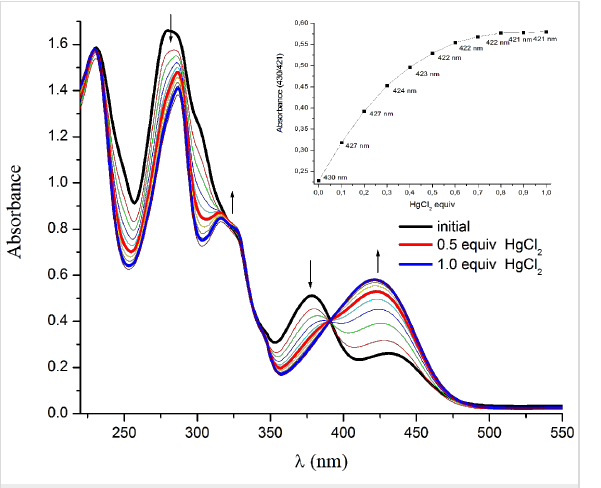
Figure 8: Absorption spectra of a 4.26 mM solution of 4a in methanol upon titration with an aqueous HgCl 2 solution (0–1.0 equivalents). Inset shows the visible absorption changes upon mercury binding.